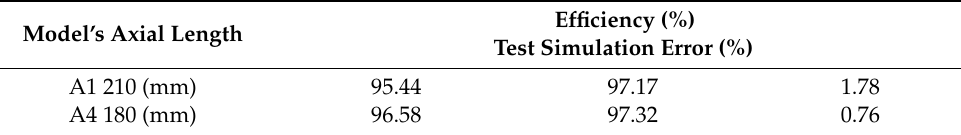
Table 12. Analytical models validation for